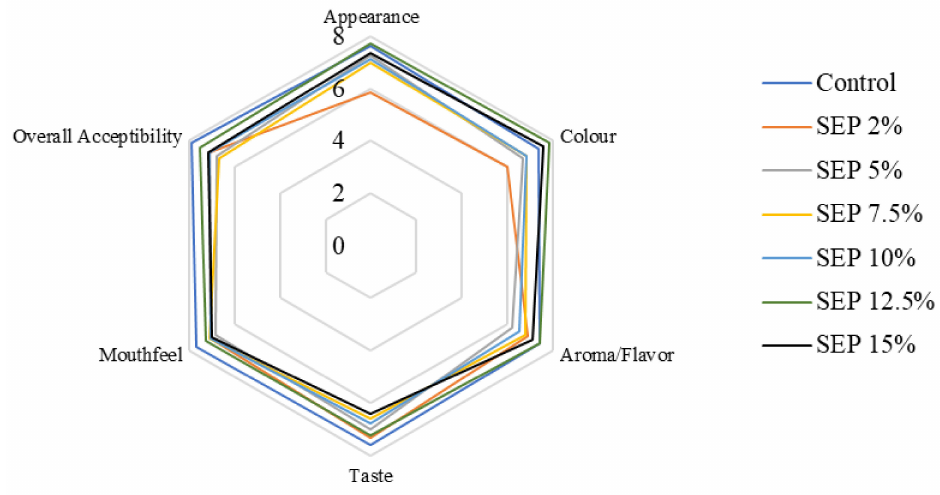
Figure 8. Acceptability scores of pasta containing different levels of Spirulina